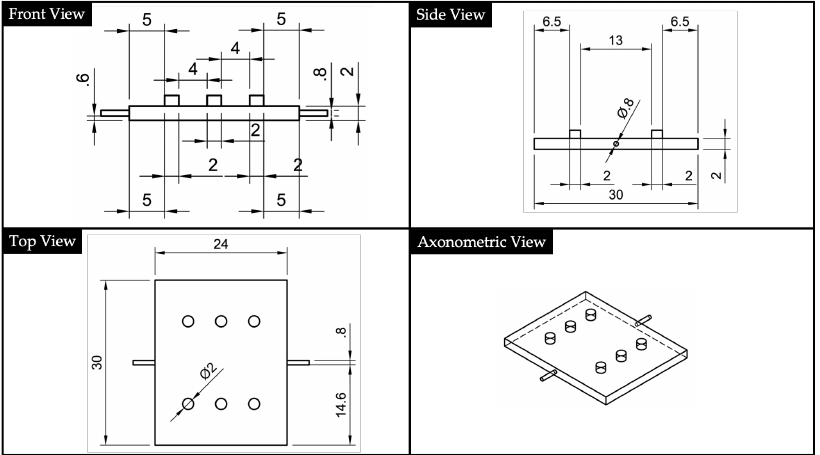
Figure 5. Cover’s 2D drawings and North-West (NW) axonometric view, obtained via Autodesk ® Fusion 360 and according with the ISO